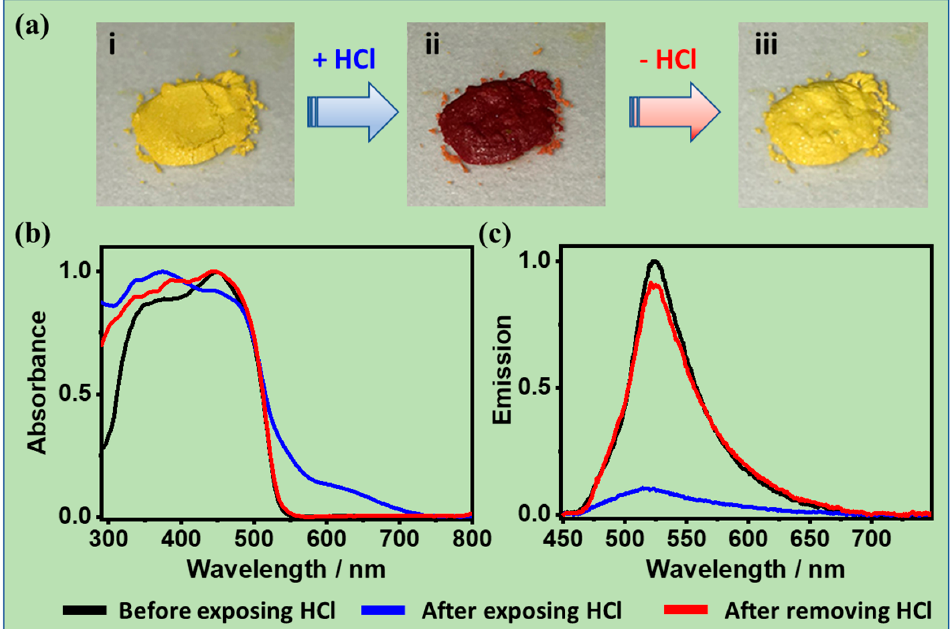
Figure 9. ( a ) Pictures showing the color changes of crystalline bulks of CPHATN-1a ( i ) before and ( ii ) after exposure to 37%-HCl, and ( iii ) after heating at 150 °C for 30 min. ( b ) Absorption and ( c ) emission spectra of solid CPHATN-1a upon exposure to HCl atmosphere for 40 min and after equilibrating the sample with ambient air for 48 h. Adapted with permission from the American Chemical Society, 2019.